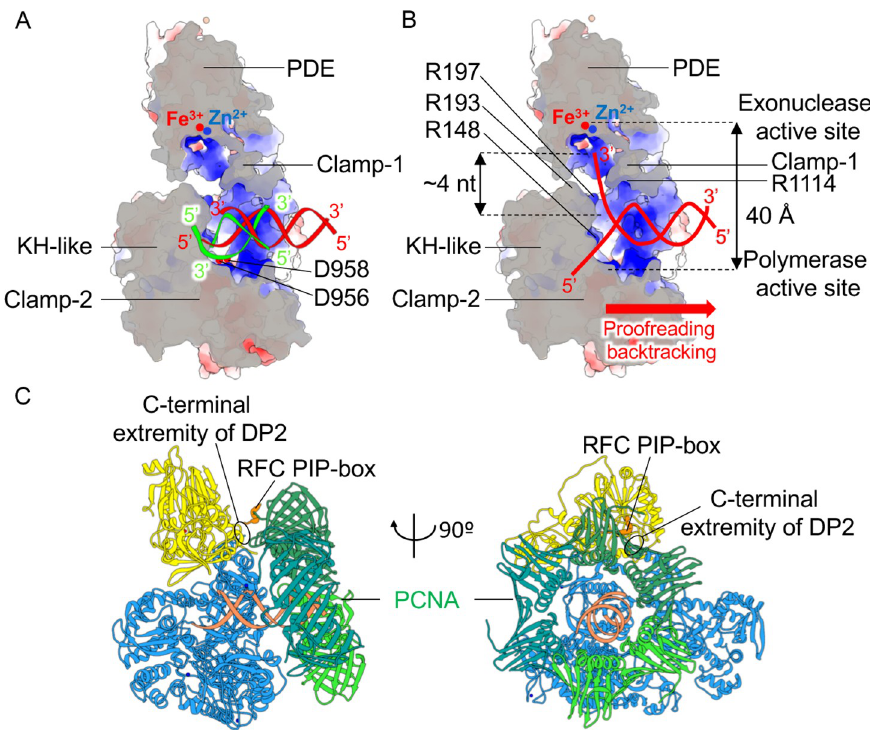
Fig 8. Proposed path for the 3 0 end of the DNA primer during elongation and proofreading by PolD. (A) Cutaway front view of PolD showing a comparison of the position of DNA in the cryo-EM structure of PolD (red) and the nascent RNA/DNA hybrid (green) in the crystal structure of the elongation complex of S . cerevisiae RNAP-II [25]. The section plane crossing PolD is represented with gray area. The structures of PolD and RNAP-II are superimposed on their two-DPBB catalytic cores, showing that the nascent DNA duplex in PolD (red) and the nascent RNA/DNA hybrid in RNAP-II (green) share a similar orientation with respect to their two-DPBB catalytic core. However, in the structure of PolD, the DP2 KH domain prevents the DNA substrate from coming closer to the DNAP elongation site. This observation suggests that in the elongation mode, the KH domain would move in order to allow the 3 0 end of the primer to access the elongation site, similarly to the finger domain in other families of DNAPs. (B) Same view as in (A) showing a putative path for the DNA being digested. The helical axis of the DNA duplex is identical to that of the DNA-bound PolD cryo-EM structure. The 3 0 end of the DNA primer is extended by approximately 4 nt toward the exonuclease catalytic site of DP1. A red arrow shows the direction of the hypothetical proofreading backtracking mode of PolD. (C) Model of the PolD–DNA–PCNA ternary complex. cryo-EM, cryo–electron microscopy; DNAP, DNA polymerase; DPBB, double-psi β -barrel; KH, K-homology; PCNA, proliferating cell nuclear antigen; PDE, phosphodiesterase domain; PIP, PCNA-interacting peptide; RFC, replication factor C; RNAP, RNA polymerase.